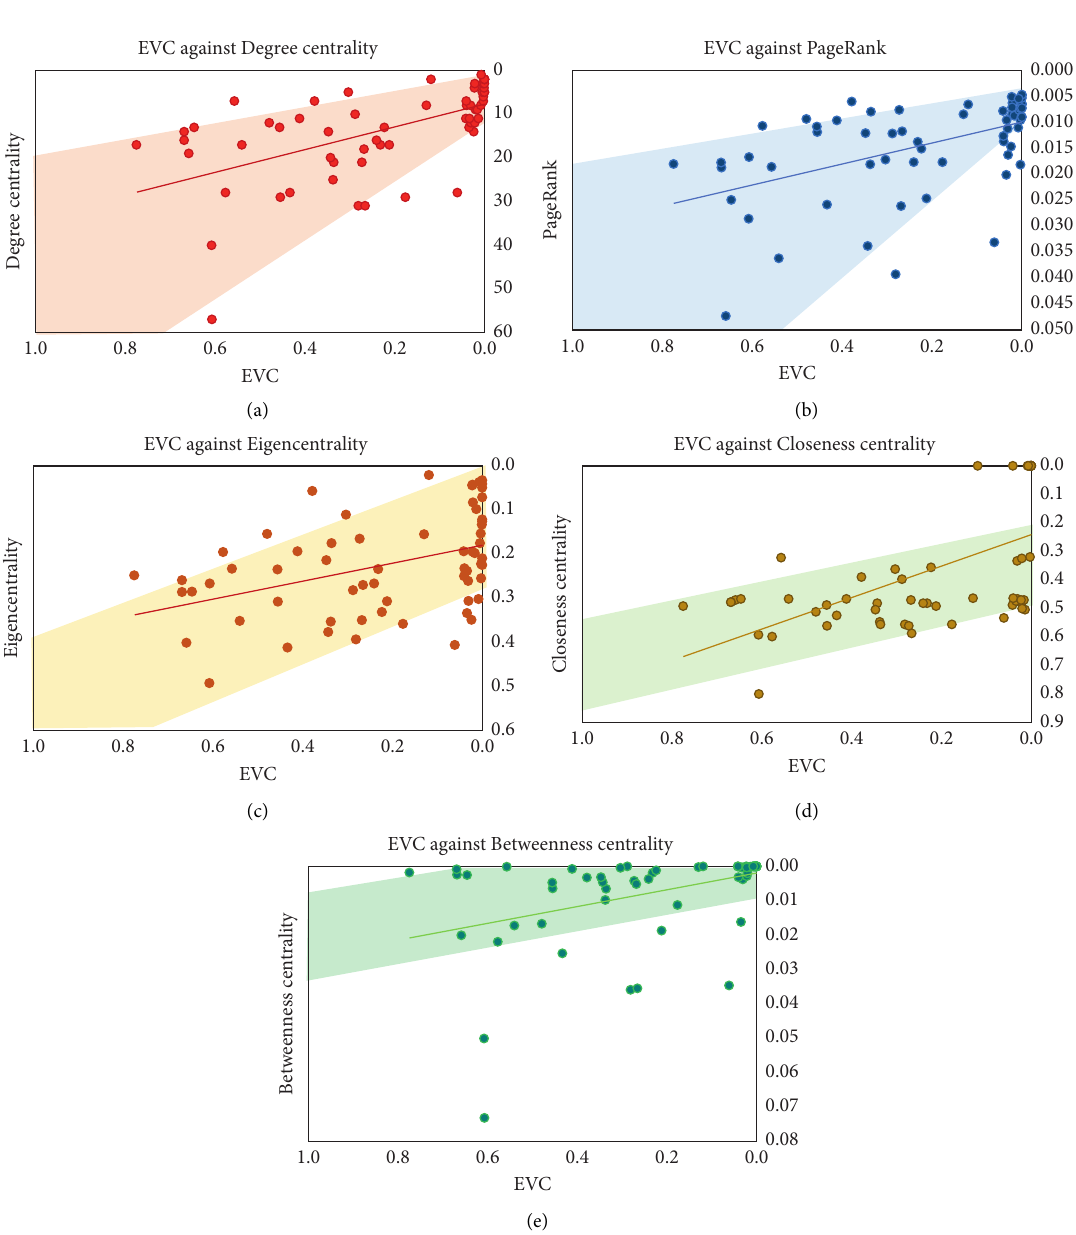
Figure 10: Scatterplots of EVC values against another centrality measure. EVC against (a) degree centrality, (b) PageRank centrality, (c) eigencentrality, (d) closeness centrality, and (e) betweenness